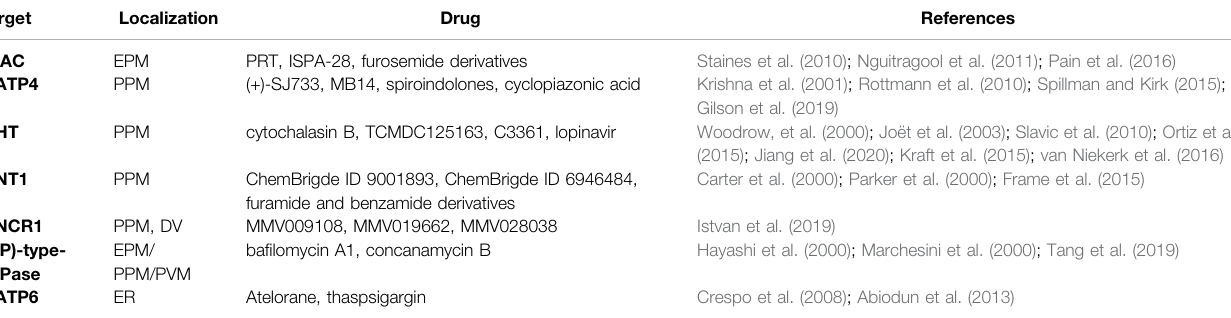
TABLE 1 | Overview of Plasmodium -infected RBC transporters tested as novel antimalarial drug targets.